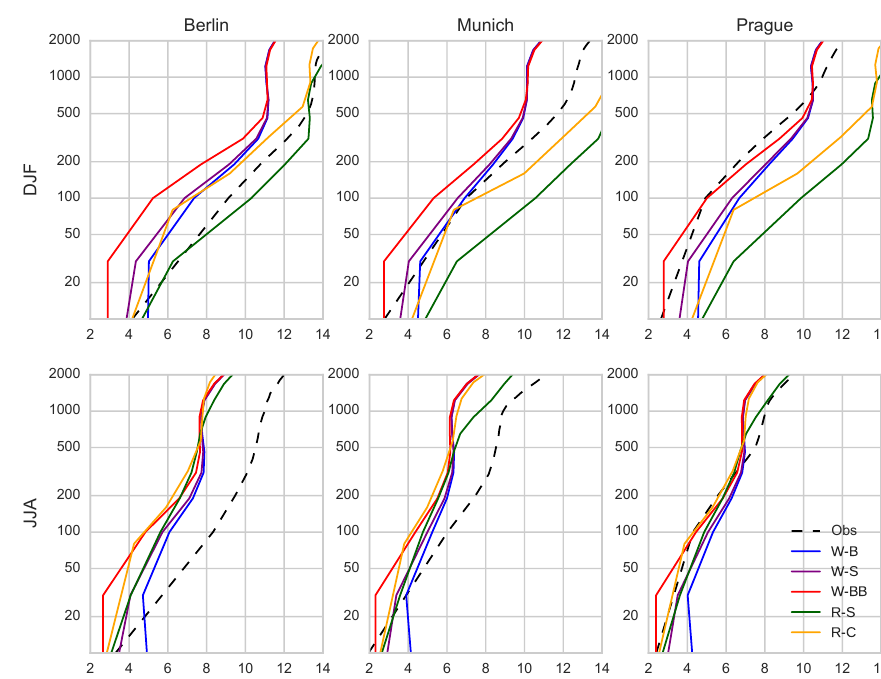
Figure 8. The averaged wind speed vertical profile (ms − 1 ) over selected cities, given by models and radiosonde observations. The y axis indicates the altitude in